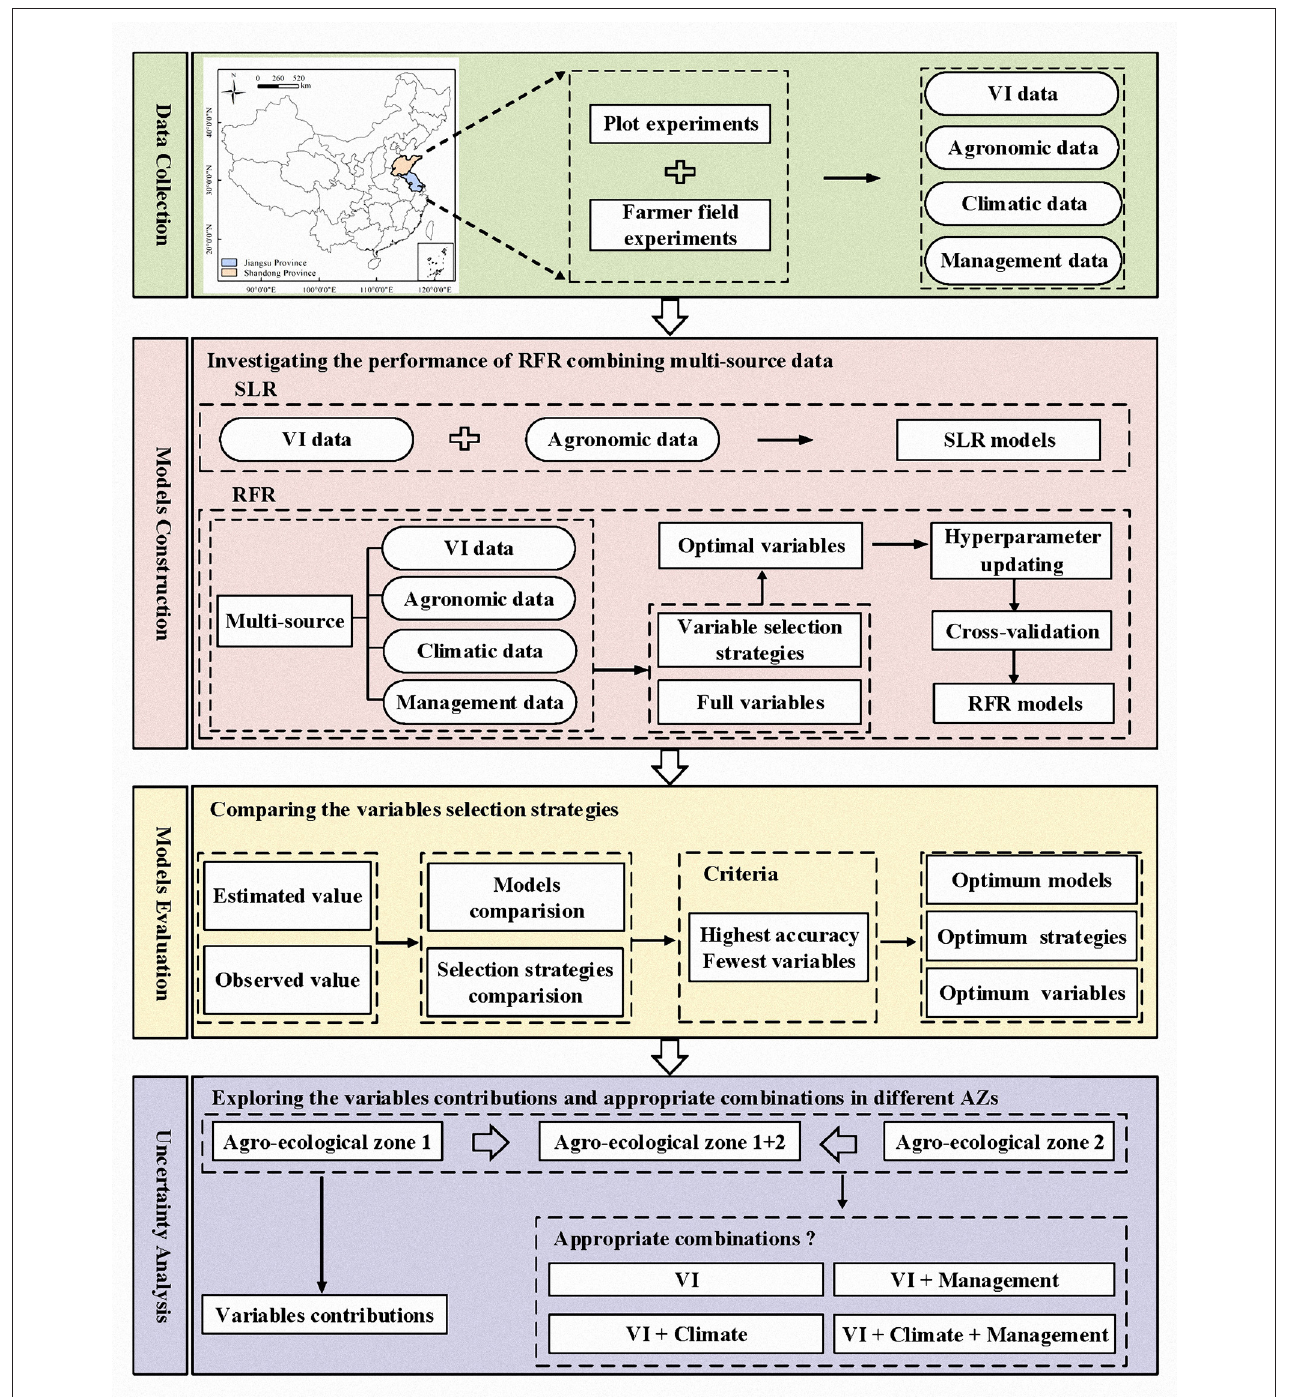
FIGURE 2 | Workflow of this